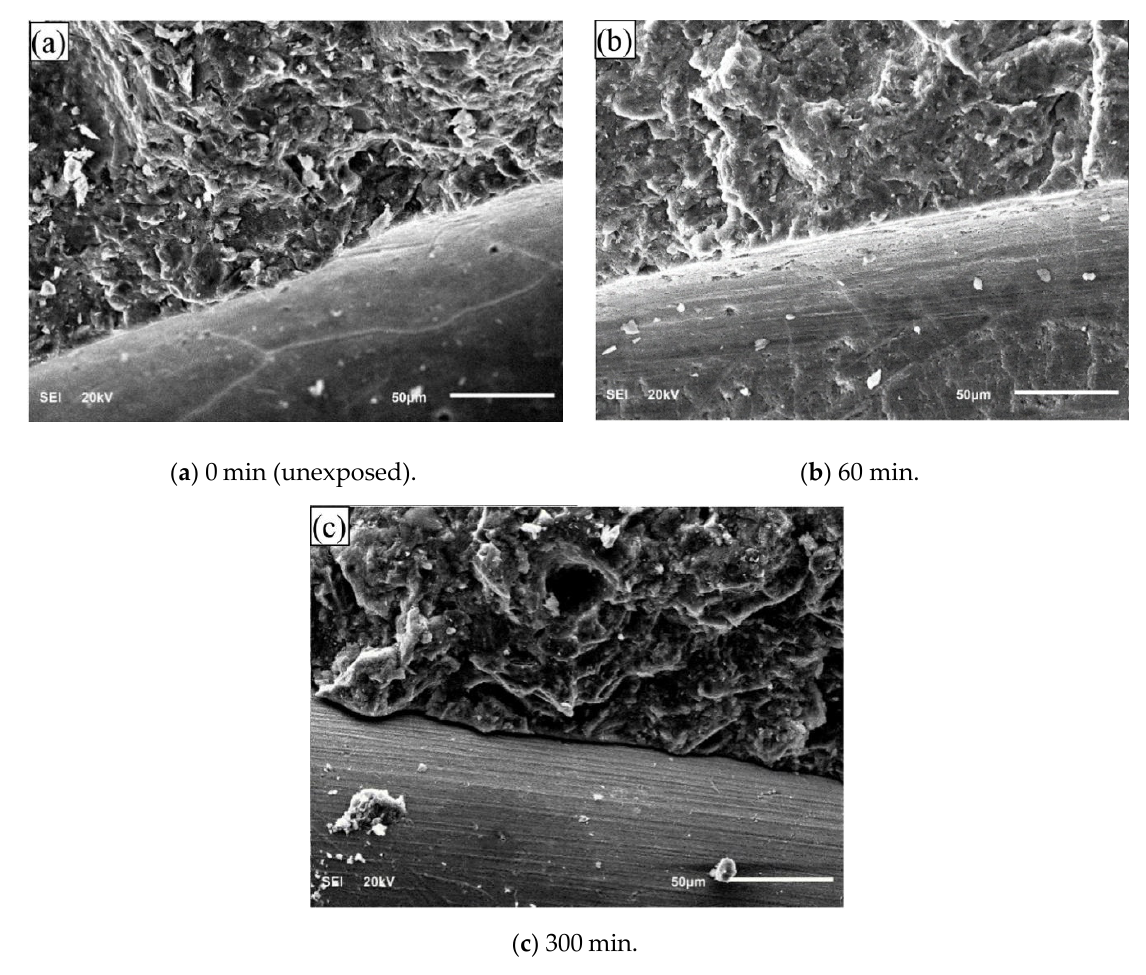
Figure 13. SEM micrograph of CRFC (Steel Fiber Reinforced Concrete) after 0 min ( a ), 60 min ( b ), and 300 min ( c ) of a high temperature of 300 °C [101].